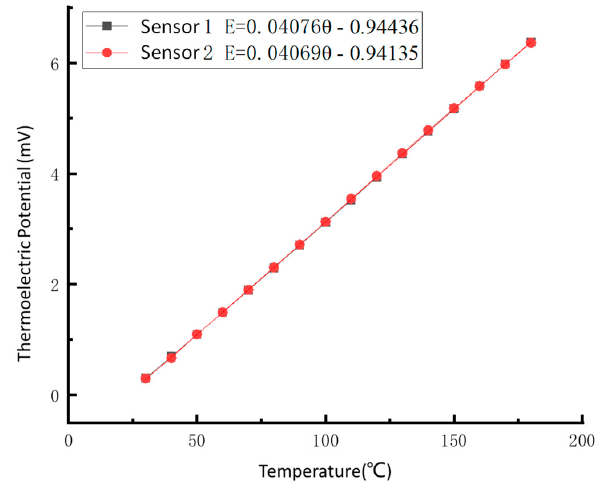
Figure 11. Static calibration curve of thin-film thermocouple temperature sensors.